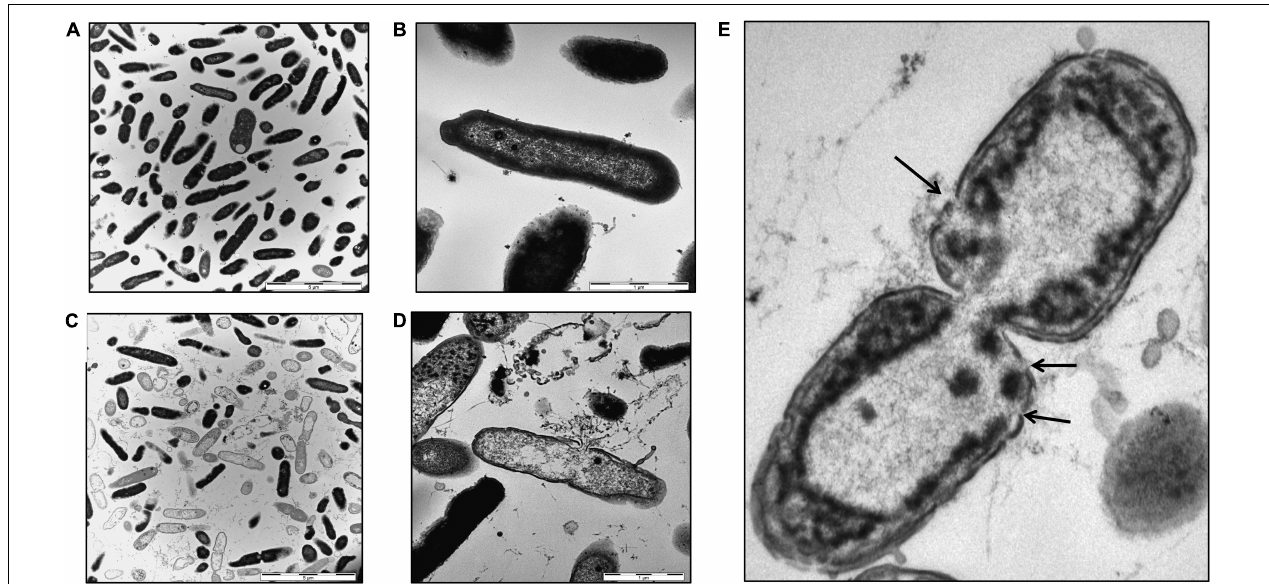
FIGURE 8 | Transmission electron microscopy images of P. aeruginosa . Bacterial cells were grown to midlogarithmic phase and exposed to buffer (A,B) or 0.1 mM HBB(112–147) at pH 4.5 for 1 h (C,D) . Cells were fixed with 2.5% glutaraldehyde and dehydrated in a graded series of 1-propanol. Following embedding in Epon, ultra-thin sections (80 nm) were collected on copper grids, and imaged in a Zeiss TEM 109 or in a Jeol TEM 1400. Areas showing loss of membrane integrity are indicted by black arrows (E) . Scale bars are 5 µ m (A,C) and 1 µ m (B,D)